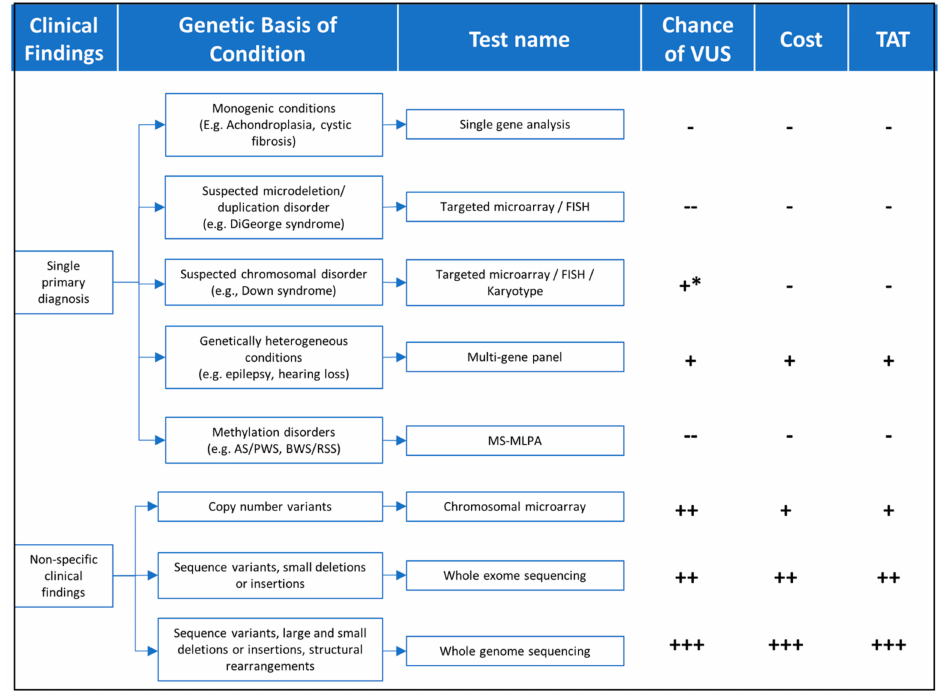
Figure 1. TAT = turnaround time; FISH = Fluorescence in situ hybridization; MS-MLPA = Methylation- Specific Multiplex Ligation-dependent Probe Amplification. Chance of VUS(–) = very low; (-) = Low; (+) = moderate; (++) = high; (+++) = very high; (+ *) moderate risk for karyotype. Cost—(-) = lowest cost (+) = moderate cost (++) = high cost (+++) = highest cost. TAT—(-) = shortest time (+) = moderate time (++) = long time (+++) = longest